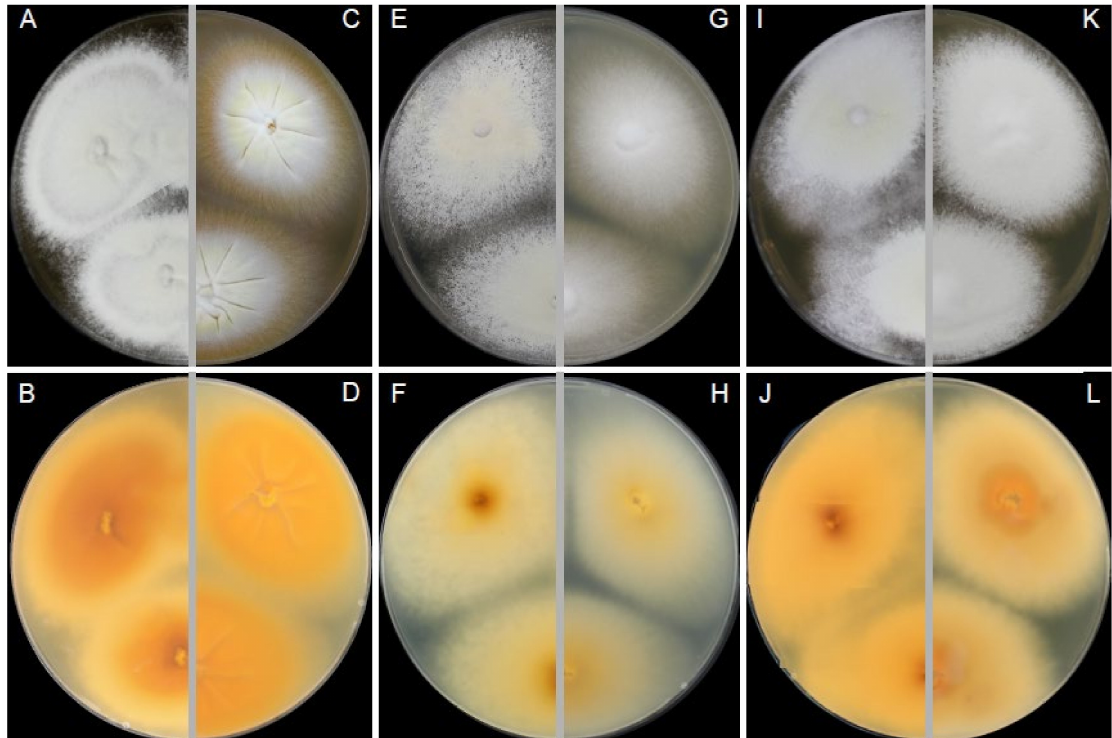
Figure 5. Macromorphology of Trichophyton mentagrophytes (left) in comparison with T. erinacei (right) isolated from European hedgehogs in France. Colonies of T. mentagrophytes after two weeks of cultivation at 25 ◦ C on Sabouraud’s dextrose agar ( A , B ), malt extract agar ( E , F ) and potato dextrose agar ( I , J ). Colonies of T. erinacei under the same conditions